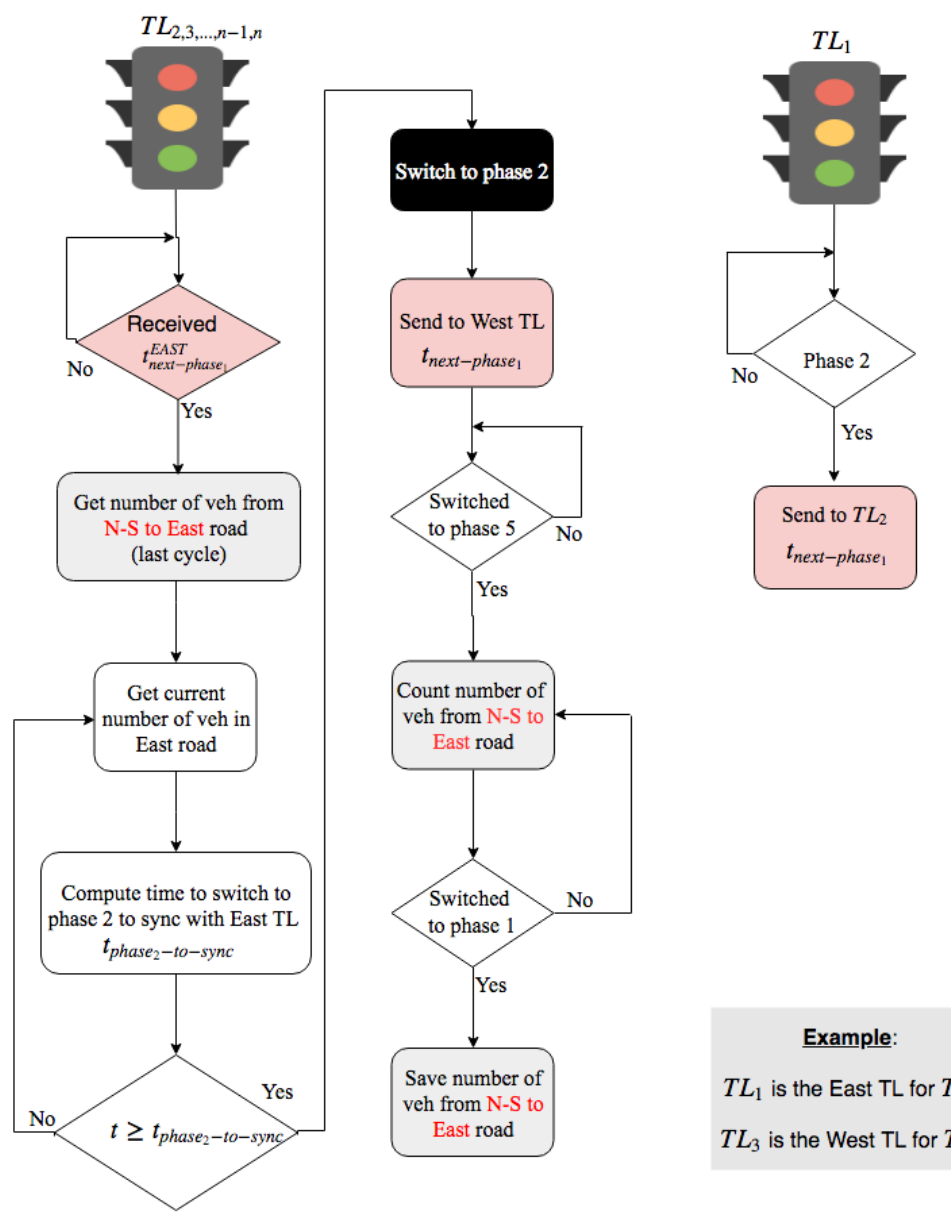
Figure 9. Illustration of TLs synchronization